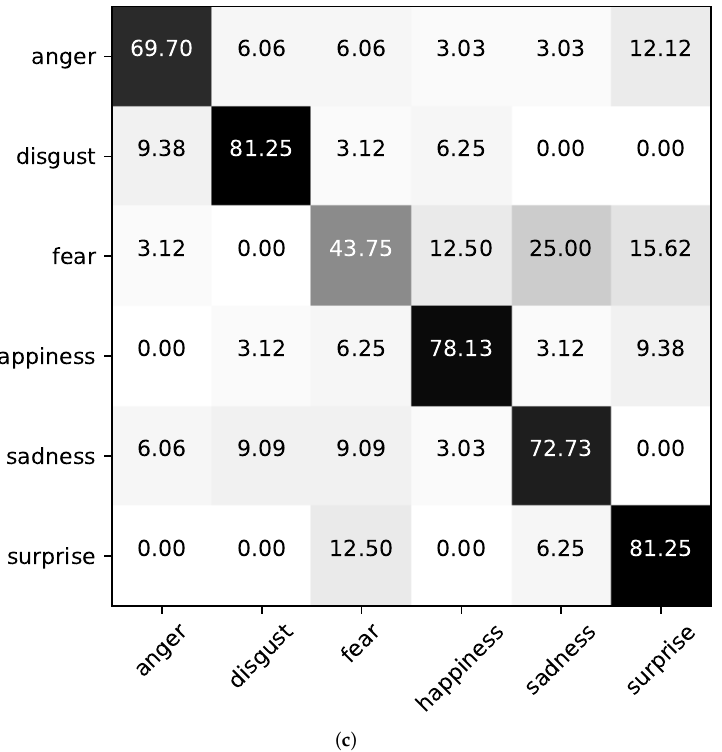
Figure 3. The confusion matrices of different methods on the eNTERFACE’05 dataset. ( a ) Baseline (A+V), ( b ) Ours (wo corr), ( c ) Ours.